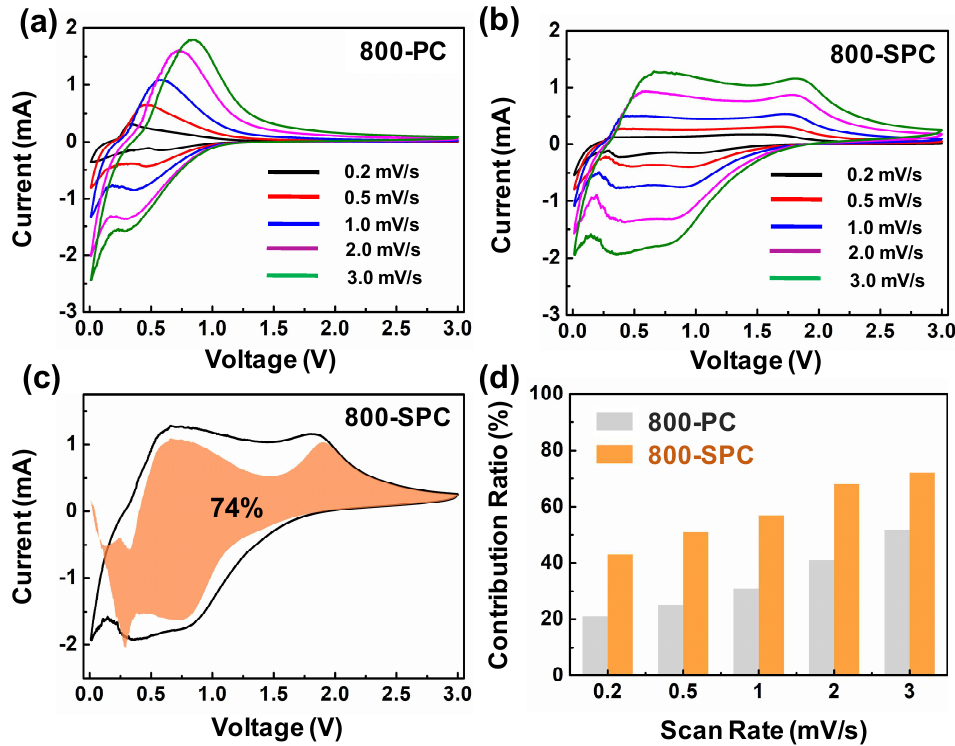
Figure 7. Capacitive contributions for storage capacity of 800-PC and 800-SPC materials. ( a , b ) respectively show the CV measurement results of 800-PC and 800-SPC materials at different scan rates. ( c ) shows the bar charts showing the capacitive contribution of 800-SPC at scan rate of 3.0 mV/s. ( d ) illustrates the capacitive contribution ratio of 800-PC and 800-SPC materials at different scan rates.